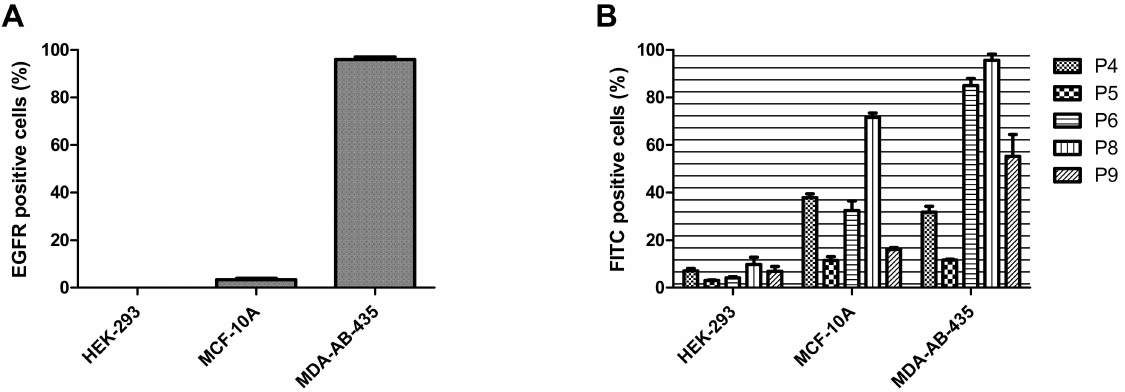
Figure 4. EGFR status and peptide internalization into HEK-293, MCF-10A, and MDA-MB-435 cells. ( A ) Flow cytometry analysis of EGFR expression in cells. Cells were treated with monoclonal antibodies against human EGFR. Expression levels were measured by the APC fluorescence intensity. ( B ) Cells were incubated with 2.5 µ M peptides for 3 h at 37 ◦ C, collected with trypsin, and analyzed by flow cytometry. The experiment was repeated three times; untreated cells were used as the control. The mean of the FITC positive cells ± SD is presented (n =